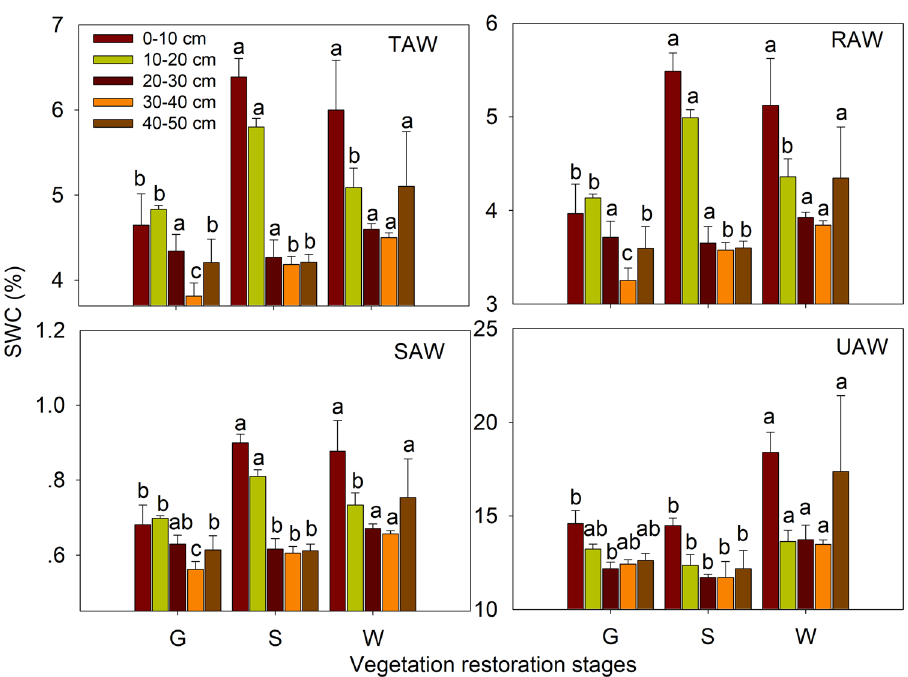
Figure 5. Total available water content (TAW), rapid available water content (RAW), slow available water content (SAW) and unavailable water content (UAW) in the different soil layers at different vegetation restoration stages (see Table 1). The values are in the form of means ± SEs, and the sample size (n) is 5. The different lowercase letters above the bars indicate significant differences within a soil layer among the different vegetation restoration stages ( P <